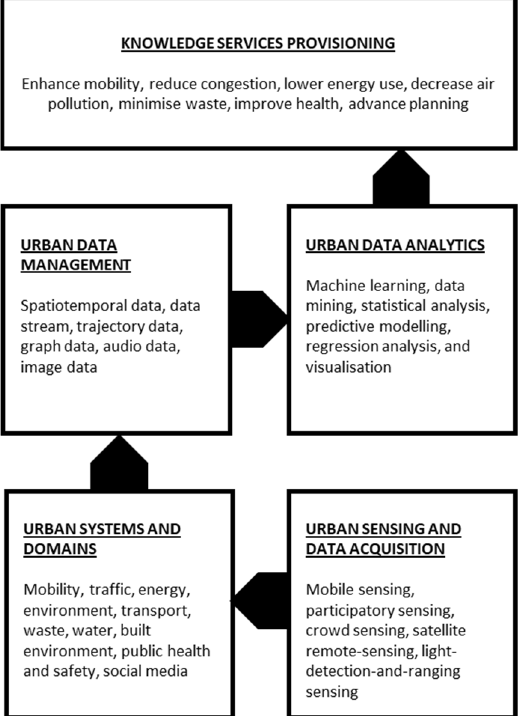
Figure 2. General architecture for urban computing and intelligence based on big data analytics. Illustration by authors.